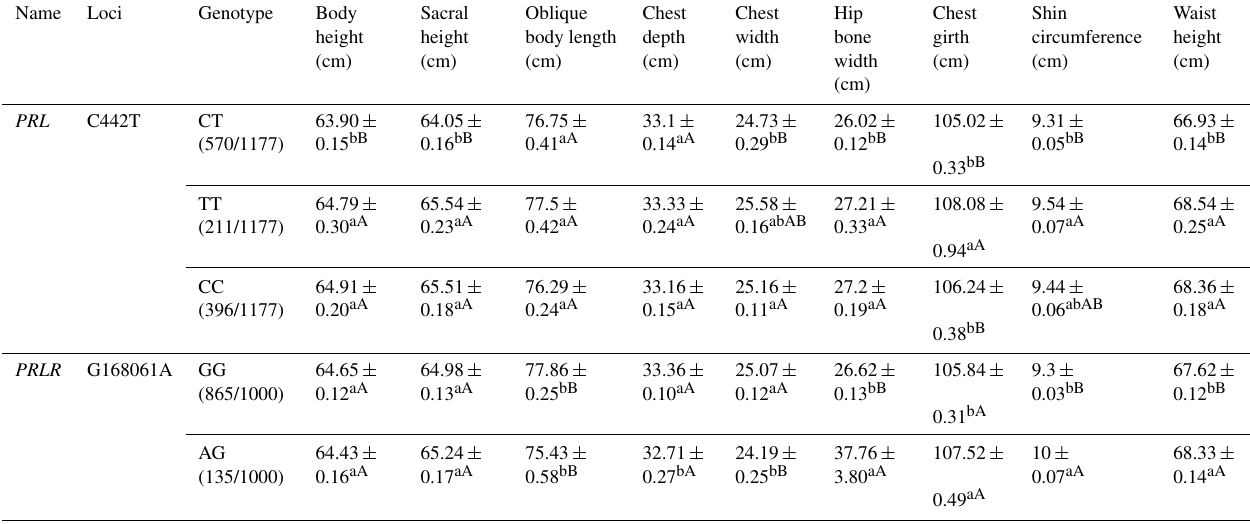
Table A5. Association analysis between PRL and PRLR gene mutation sites and body size. Name